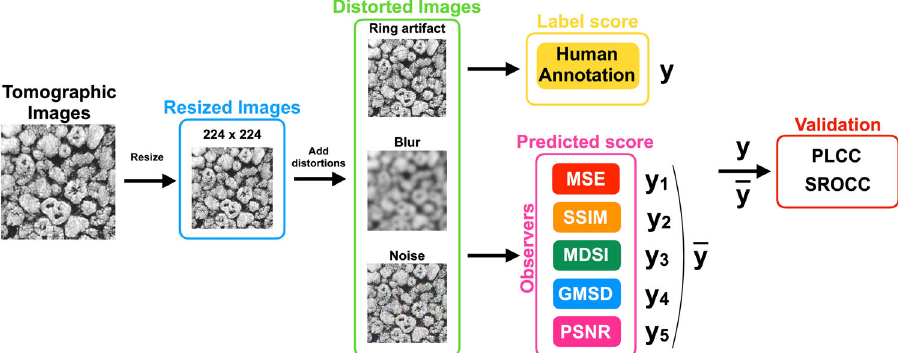
Fig. 2 Detailed structure of data generation. The observers are some FR-IQA methods. y is the human annotation, y i is the predicted score of the i th observer, y is the average score of y i .